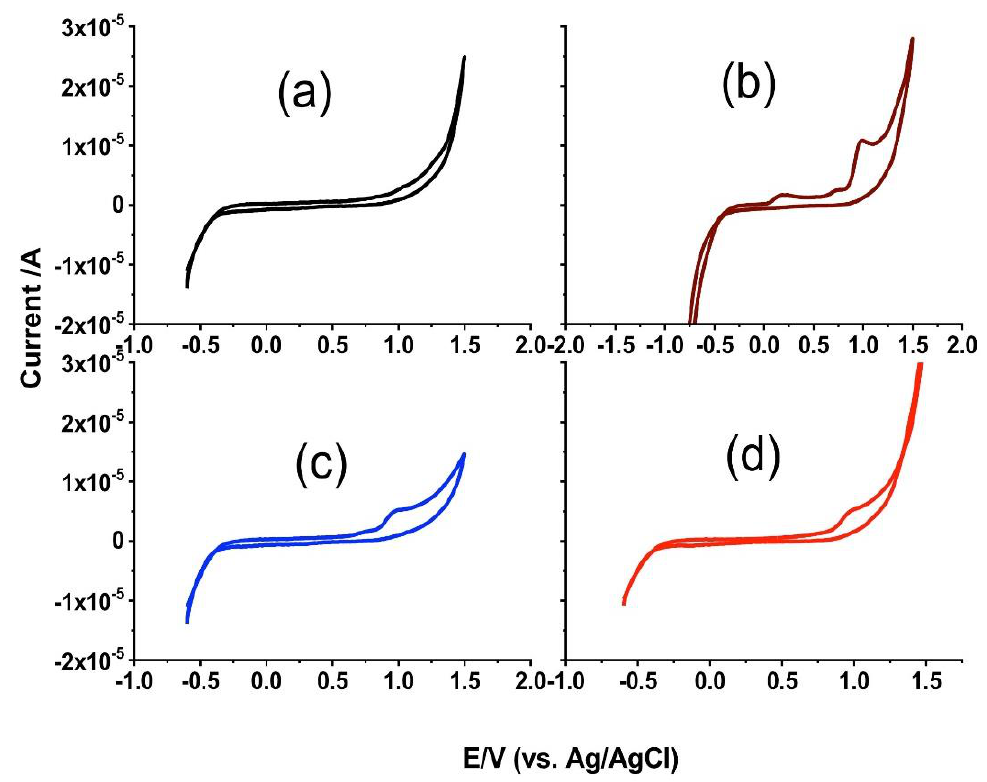
Figure 7. Cyclic voltammograms of 1.0 mM of p -nitrophenol at a CPE modified with Zn(II) complex 2 at different pH values: ( a ) 7, ( b ) 8, ( c ) 9 and ( d ) 10; scan rate = 50 mV/s.